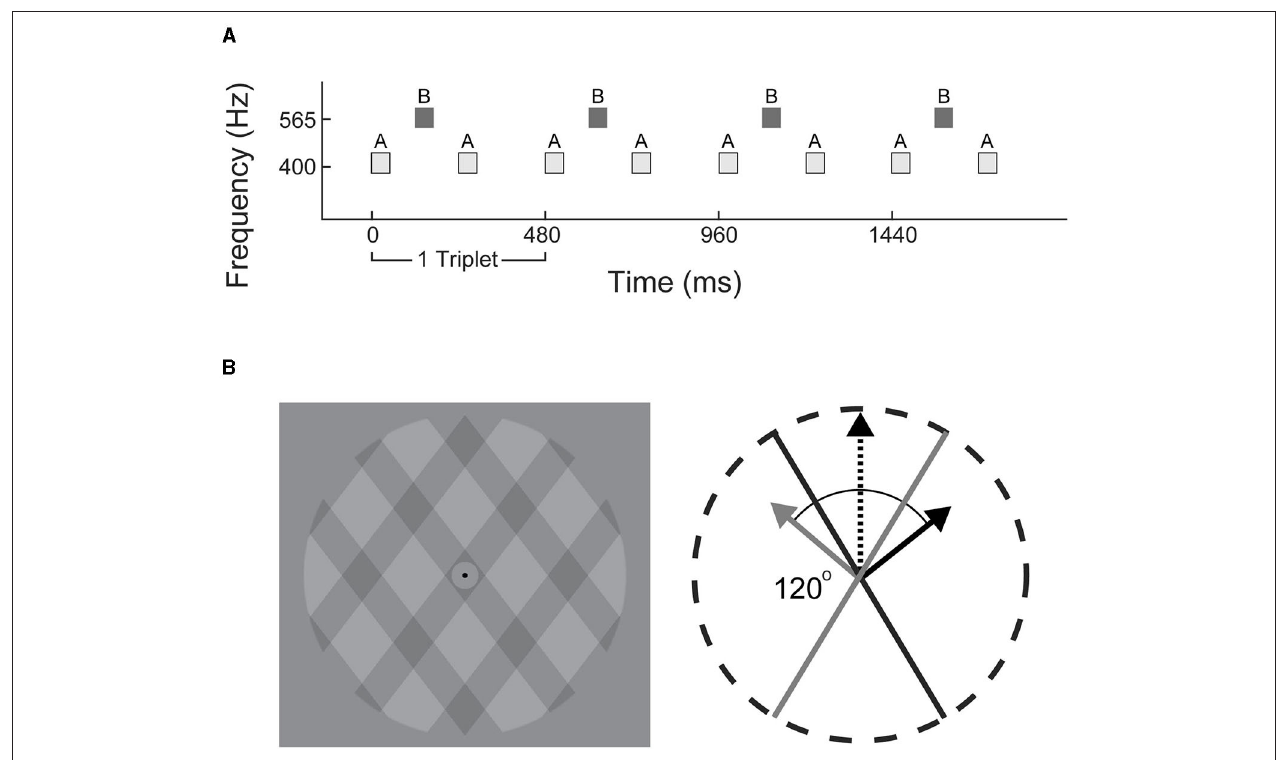
FIGURE 1 | Stimulus schematics. (A) Experiment 1: triplets of tones in low-high-low (ABA_) configuration were used to generate alternating integrated (ABA) or segregated (A-A–, -B–) percepts. (B) Experiment 2: visual plaid paradigm consisted of translucent grids overlaid at 120 ◦ angle. Each frame incrementally shifted at a rate of 60Hz to generate apparent motion in an integrated upwards (black dashed arrow), or segregated outwards direction (solid gray and black